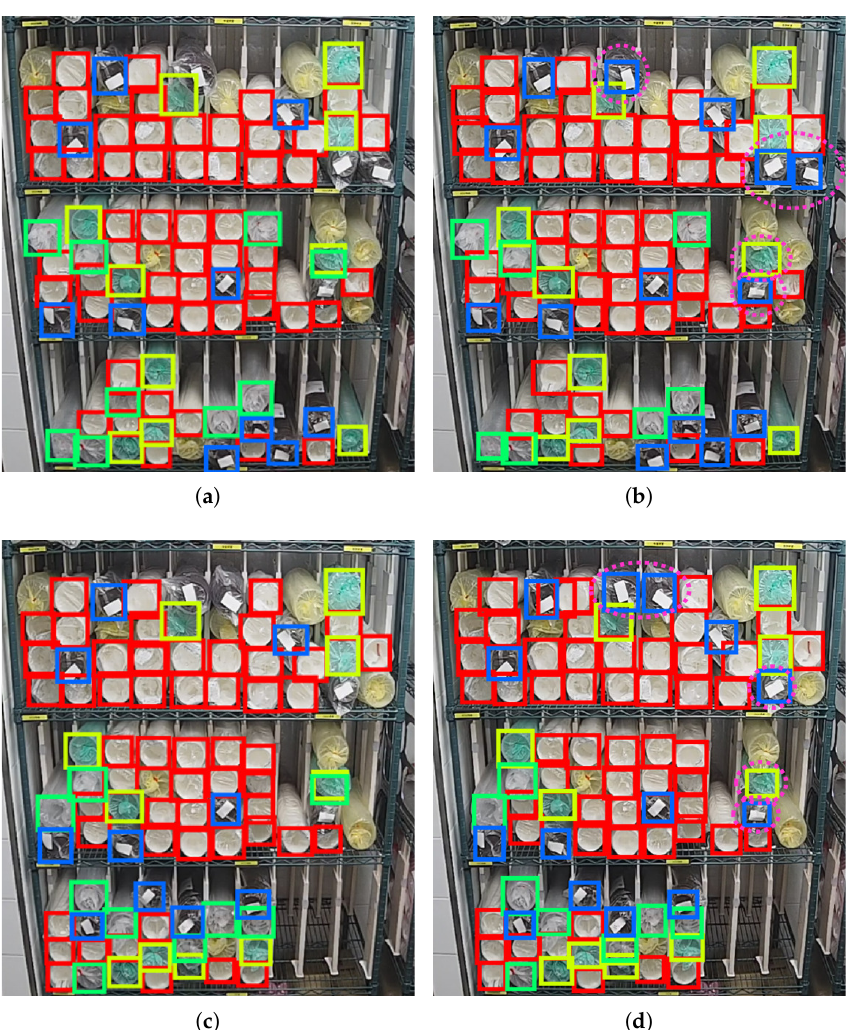
Figure 15. Comparison of detection results of original YOLOv3 and our proposed method. ( a , c ) Re- sults of original YOLOv3. ( b , d ) Results of our proposed